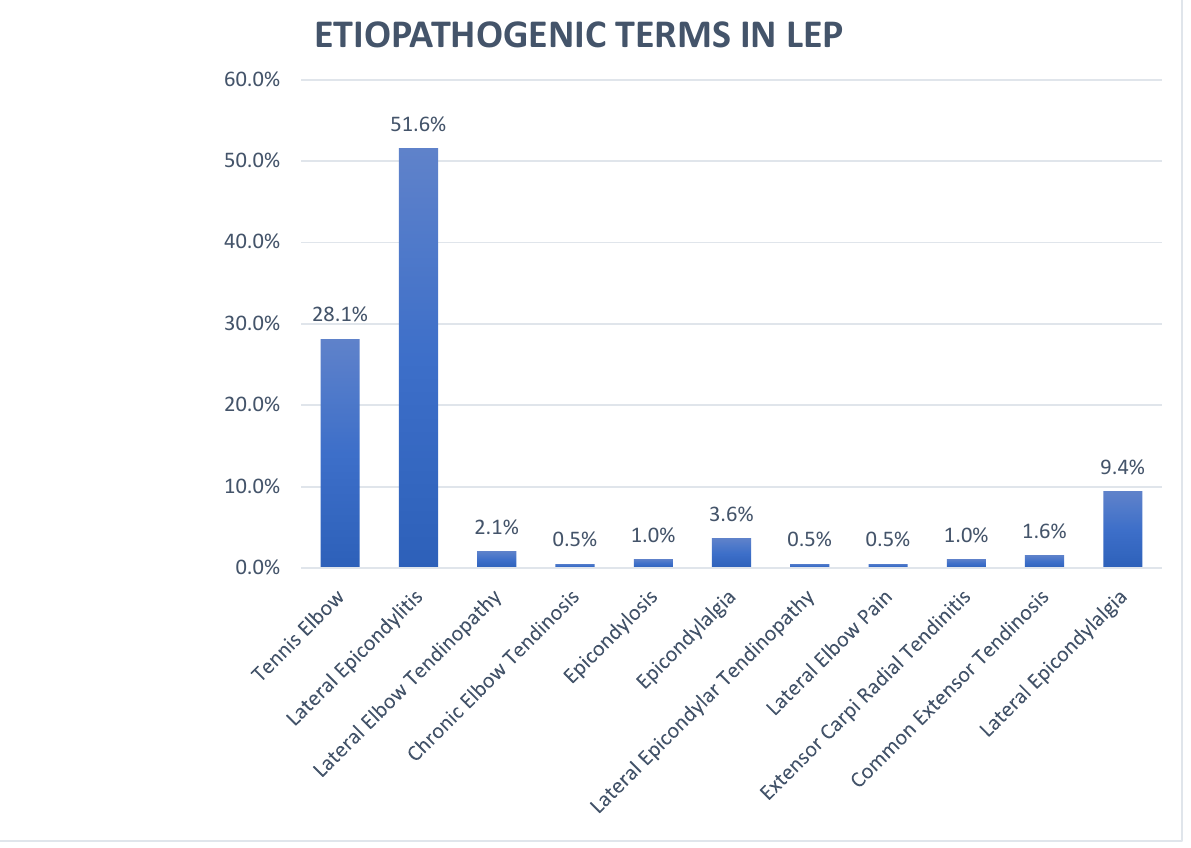
Figure 2. Terminology for lateral elbow pain (LEP); legend: LEP—lateral elbow pain.